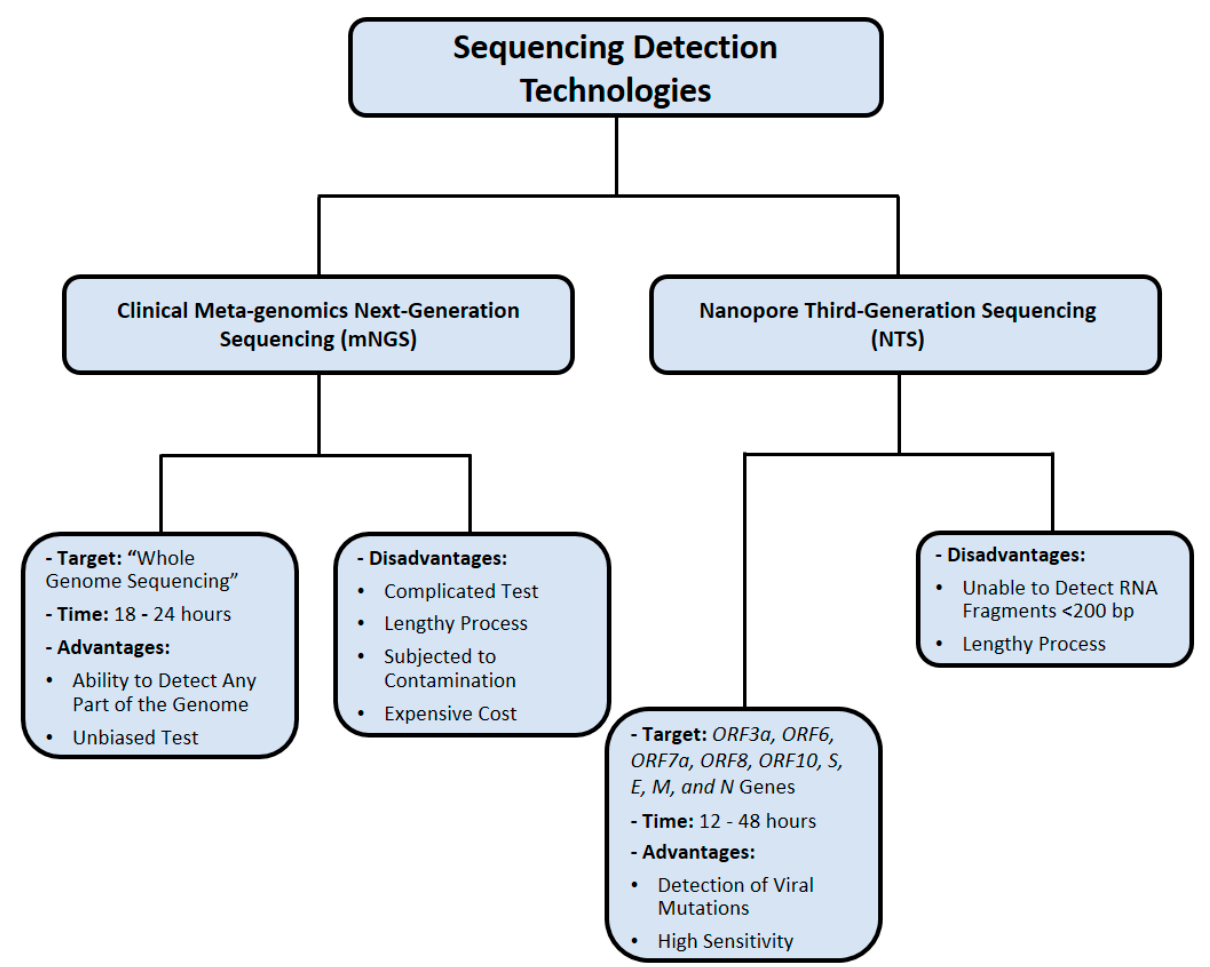
Figure 6. Nucleic acid sequencing methods used for SARS-CoV-2 detection. Data were obtained from several published reports [102–105,111–115].